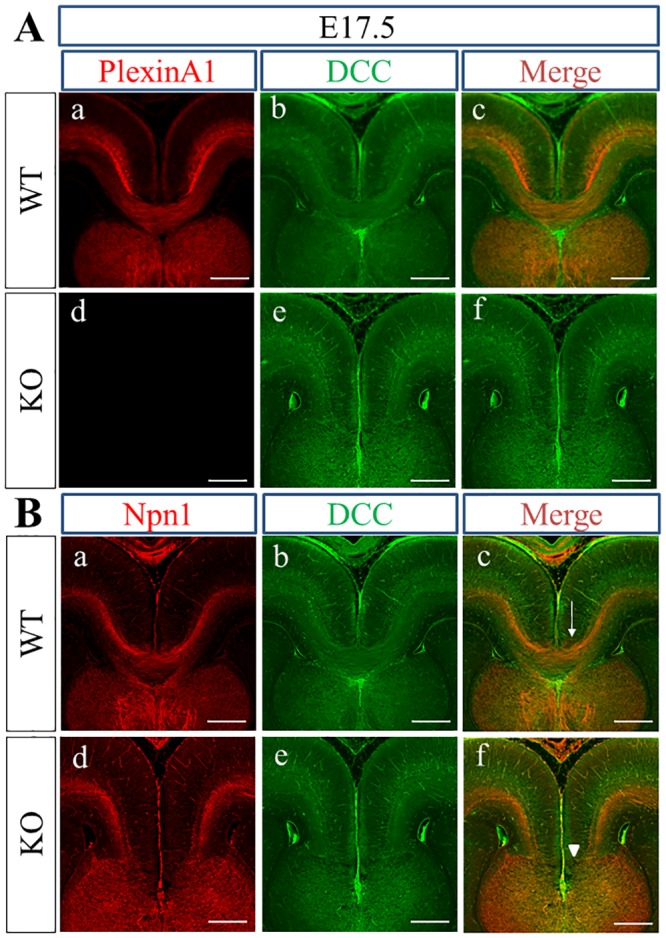
Localization of PlexinA1, DCC, and Npn1 in WT and PlexinA1 KO brains at E17.5.(A) At E17.5, PlexinA1 is expressed alongside DCC in cingulate axons and neocortical callosal axons crossing the midline in WT mice brains (c), whereas only DCC is detected in PlexinA1 KO brains (f). (B) Expression of Npn1 (red) is overlapped with the dorsal side of the DCC+ area (green) in WT (a, b, c) and PlexinA1 KO (d, e, f) mice brains at E17.5. Callosal axons fail to cross the midline (arrowhead in f) in PlexinA1 KO brain sections but do cross the midline in WT brain sections (arrow in c). Scale bars: 200 μm.